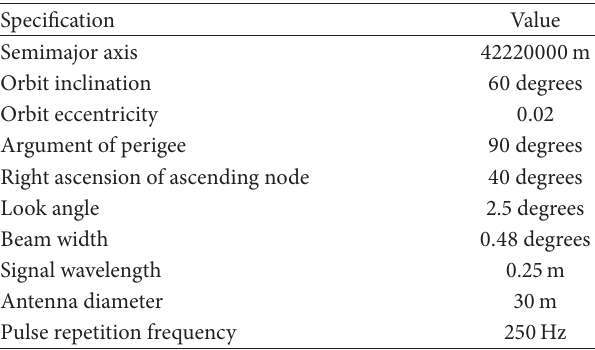
Table 1: System parameters of GEO